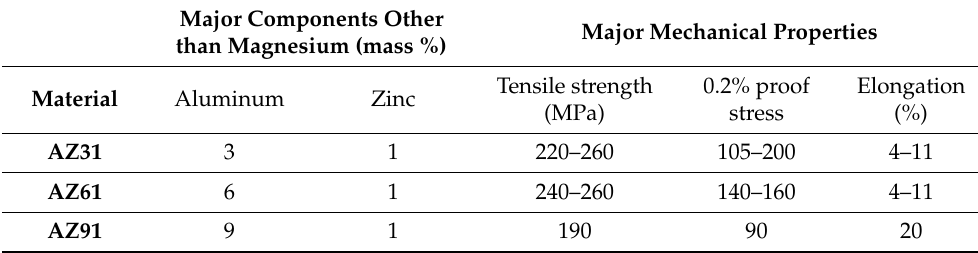
Table 1. Major composition and mechanical properties of each magnesium alloy material [20].